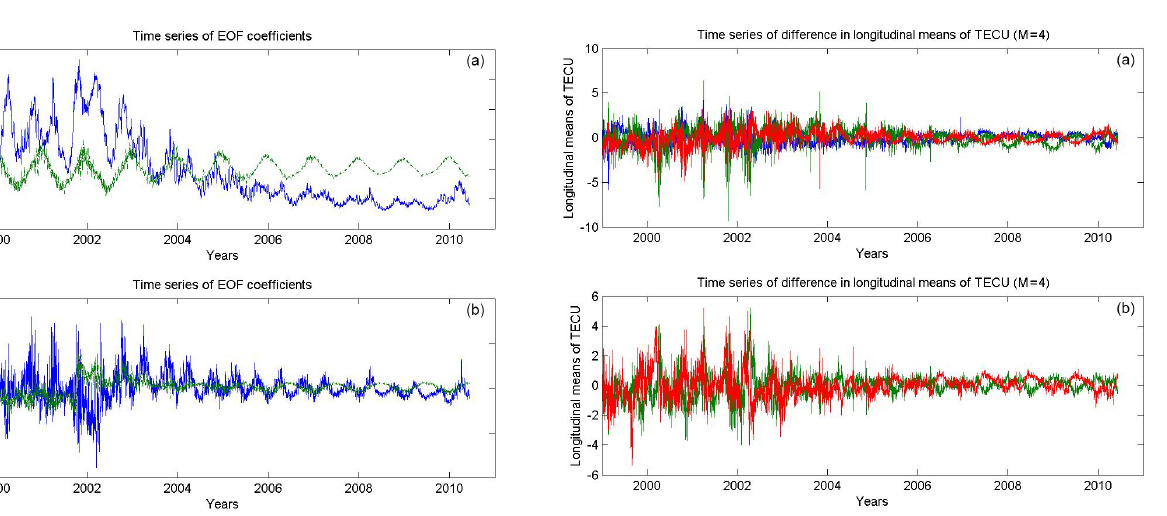
Figure 9. Time series of the principal components of the PCA for the first four EOFs shown in Fig. 2: E 1 ,n ,E 2 ,n – blue, green lines in panel (a) ; E 3 ,n ,E 4 ,n – blue, green lines in panel (b) .